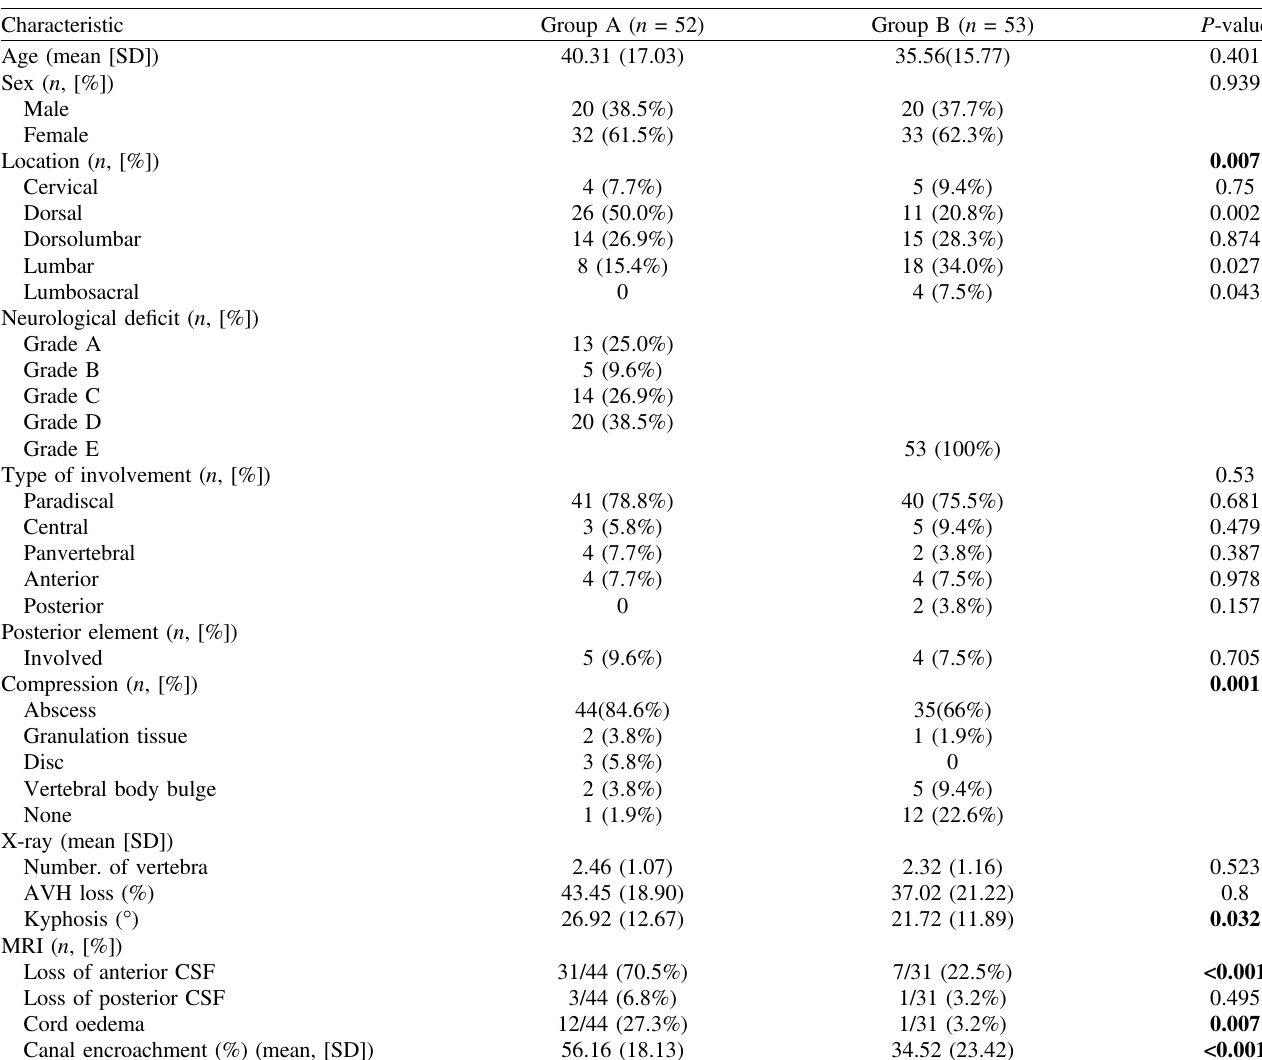
Table 1. Descriptive data of the patients ( N =